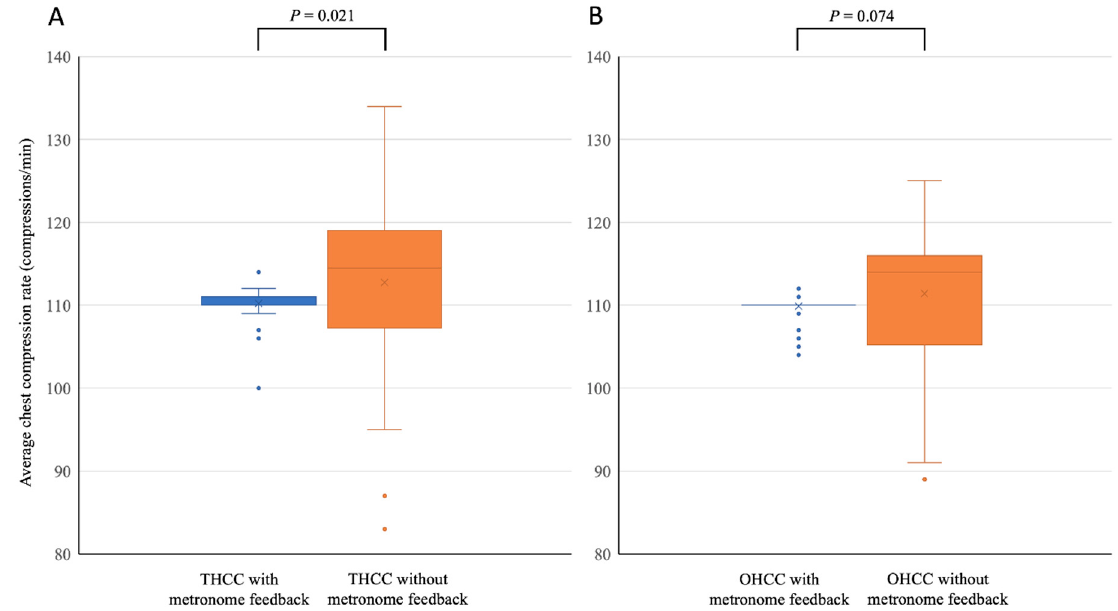
Figure 4. Comparisons of average chest compression rates during cardiopulmonary resuscitation performed with and without audio feedback provided using a metronome. ( A ) Pediatric cardiopulmonary resuscitation performed using the two-handed chest-compression (THCC) technique; ( B ) pediatric cardiopulmonary resuscitation performed using the one-handed chest-compression (OHCC) technique.